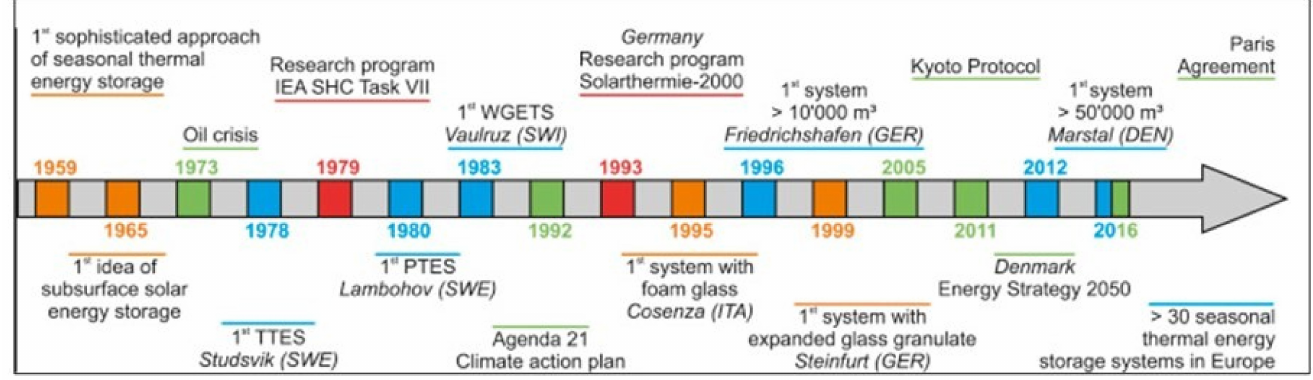
Figure 10. Timeline of the most important actions towards thermal energy storage (color-code as presented by Cristoph B. et al., green: climate actions, orange: inventions, red: research activities, blue: milestone projects) Reprinted with permission from Ref. [19]. Copyright 2022